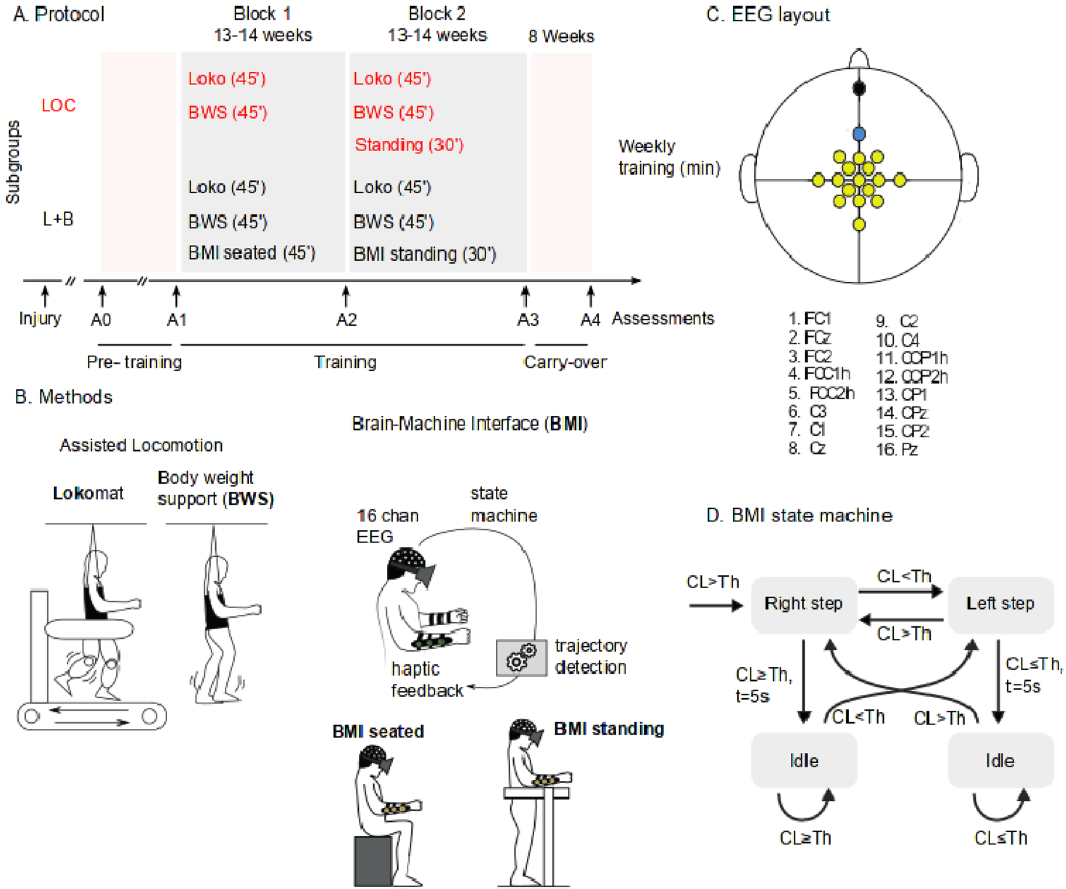
Figure 1. Experimental protocol. ( A ) Training protocol for the Locomotion only (red) and Locomotion + BMI (black) groups. A0 to A4 are clinical assessments. The Pre-training is the period going between the baseline measurement performed by the clinical institution that followed the individual before our protocol began and the onset of our protocol. The training phase contains two blocks of 13–14 weeks of training, and the carry- over phase goes between the end of the protocol and 8 weeks after the training. ( B ) Both LOC and L + B groups followed the assisted locomotion training, consisting of one Lokomat and one ZeroG training per week. The BMI training consisted of leg motor imagery to control an avatar and sensory feedback provided on subjects’ forearms ( C ) The 16 EEG electrode placement with the (R)eference and (G)round. ( D ) Left and right step animation on the avatar were triggered if the output of the linear Classifier (CL) was respectively below or above a certain threshold (− 1, + 1). If the subject did not alternate for 5 s, the avatar moved to an idle bipedal movement. Each trial was followed by a 1–3 s intertrial period during which participants could readjust themselves. Forty trials (20 left, 20 right) were conducted per classifier training, lasting approximately 8 min in total. The raw signals were sampled at 2000 Hz and processed by applying a zero-phase band-pass Butterworth filter from 8 to 30 Hz, capturing alpha and beta waves. We measured the power spectrum of the epoched mul- tidimensional time series (1-s window length with a 0.0625-s interval between consecutive windows) and used the Common Spatial Pattern (CSP) for feature extraction. Finally, we used a linear discriminant analysis (LDA) over the 6-dimensional features extracted by the CSP to construct the EEG classifier. Each classifier was scored based on fivefold cross-validation. A second training session was run if the classifier score was lower than 70%. The BMI training consisted of alternating left and right leg motor imagery (MI) to trigger the correspond- ing stepping of a 3D avatar projected in a head-mounted display (Oculus Rift DK1) showing a virtual reality environment 1 (Supplementary Fig. S2A). Each session consisted of four blocks of 6 min. We used the CSP and LDA parameters calculated during the calibration phase to decode the MI and control the stepping of the avatar. A custom C++ code running at 100 Hz updated the avatar movements (Fig. 1D) based on the classifier output with a moving average over 500 ms. The avatar steps were chosen to be small to ensure good visibility of the legs during the walk: the steps were 7.25 cm long. If the participant stopped alternating for at least 5 s, a walk-to- stop animation was triggered, and the avatar moved to an idle position. After the idle state, the participant had to trigger the step contralateral to the step before the stop: this prevented that non-alternating strategy to result in a step–stop–step–stop loop. The participant was instructed to perform as many steps as possible and to stop when randomly placed stop cues appeared in the virtual environment. Stop cues were 30 cm wide and randomly spaced by 80–130 cm from each other. Example of one trial is shown on supplementary Movie S1. We measured